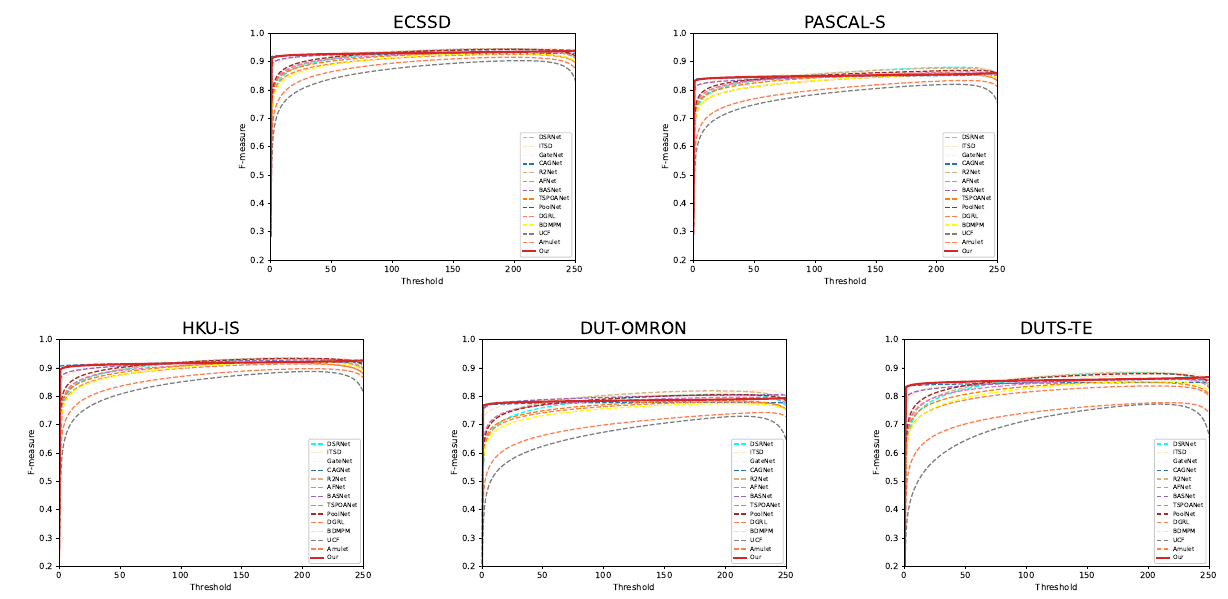
Figure 6. Quantitative results of F m curves for GSCINet and other SOD methods on the five saliency detection